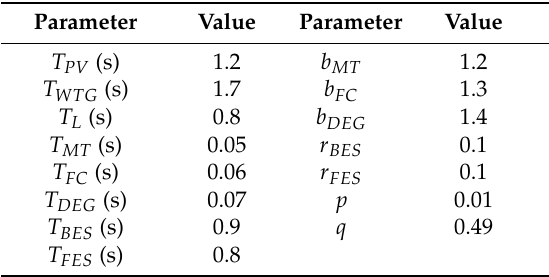
Table 1. System parameters.